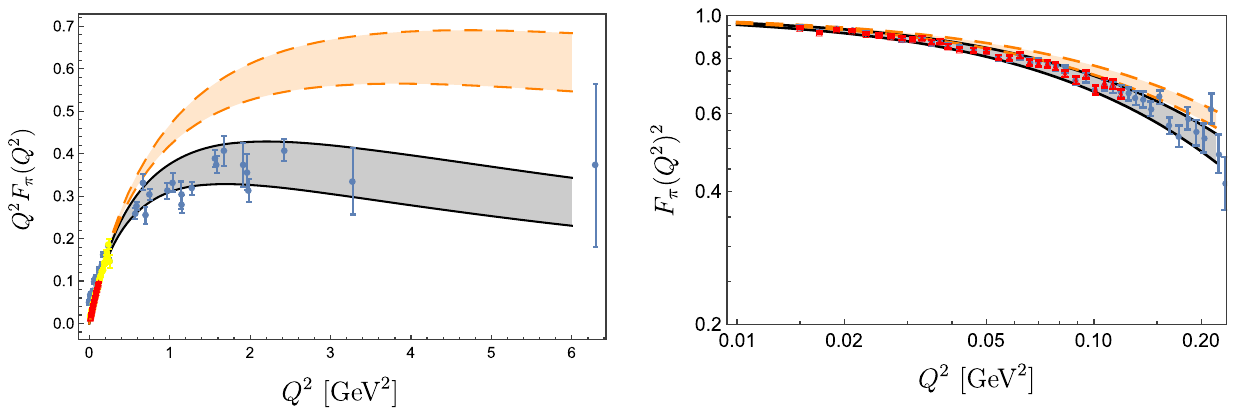
Fig. 1 The pion ff Eq. (40). Full lines for the GSWL2 model and dashed lines for the GSWL1 model. Data from Refs. [47–53]. Left panel for Q 2 F π ( Q 2 ) . Right panel for | F π ( Q 2 ) | 2 . Bands stand for the error in